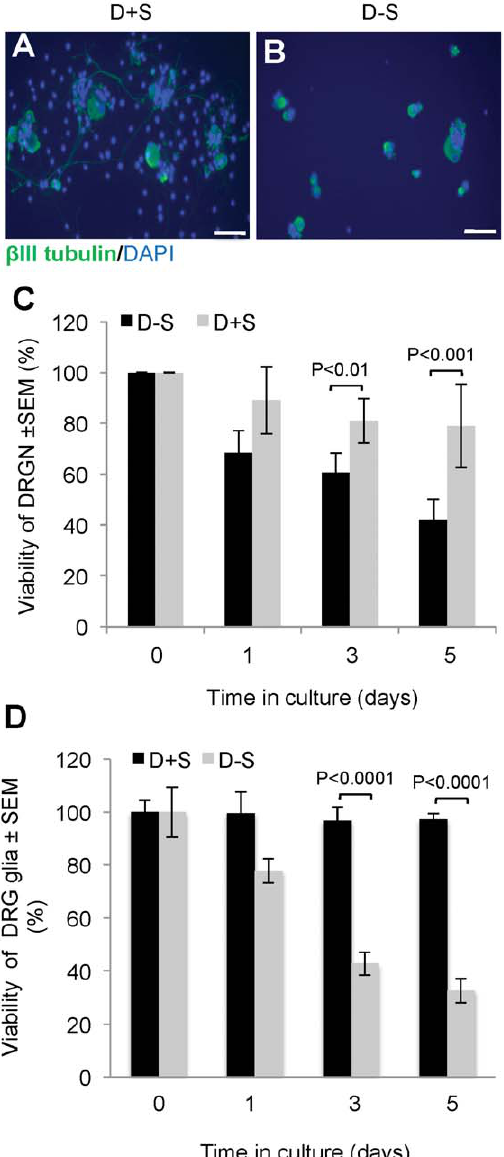
Figure 3. Survival of DRGN after 5 days in culture, in the presence of serum and after serum withdrawal. DRGN grown in A , presence of serum (D + S) or, B , after serum withdrawal (D 2 S). C , DRGN and D , DRG glia survival in the presence of serum and after serum withdrawal, over time in culture. The data presented here are means 6 SEM from 3–5 separate experiments conducted in duplicate. Figure 4. CASP2 is activated in serum-withdrawn DRGN and